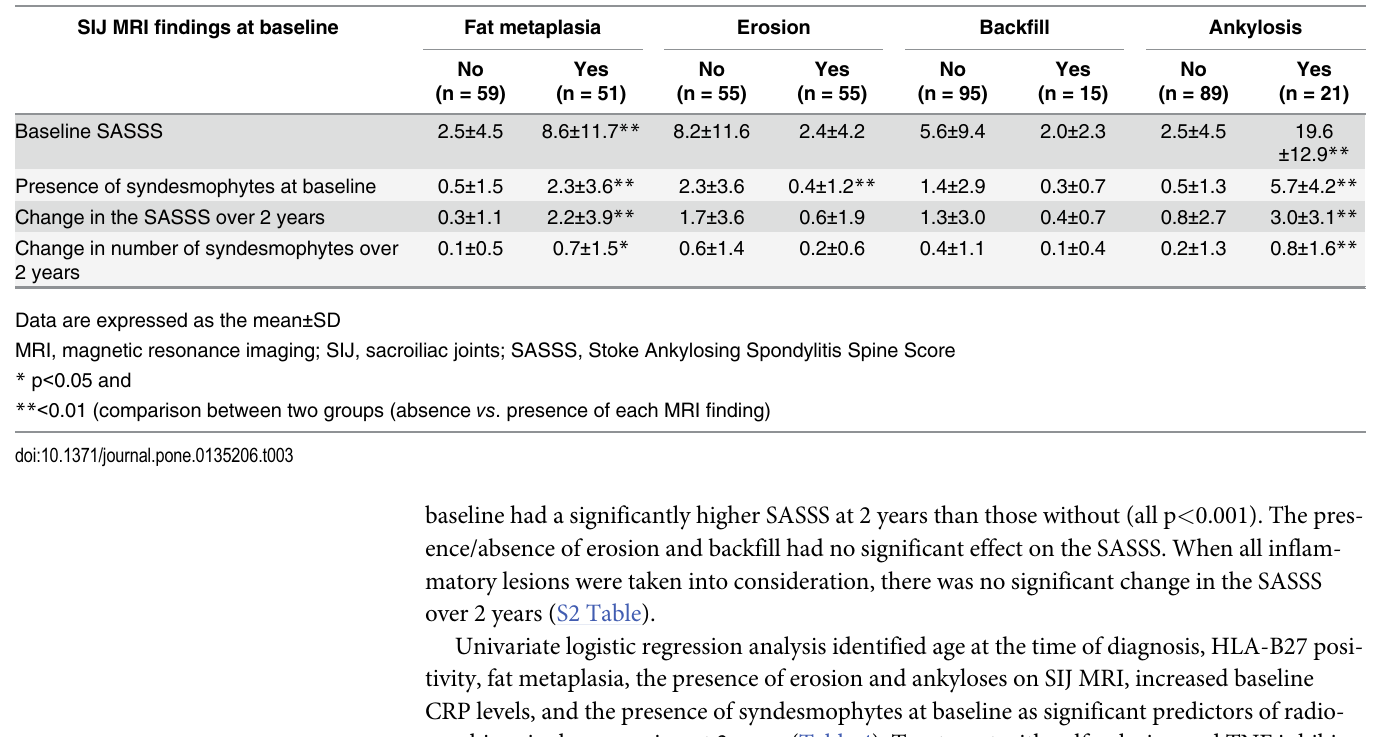
Table 3. Spinal radiographic progression over 2 years accoding to structural lesions in the sacroiliac joints observed on baseline MRI. SIJ MRI fi ndings at baseline